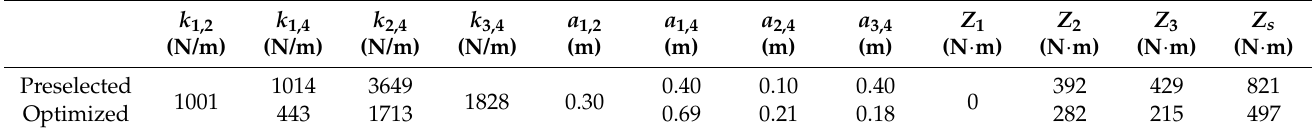
Table 3. Preselected and optimized spring stiffness, spring preattachment length, and peak magnitude of internal